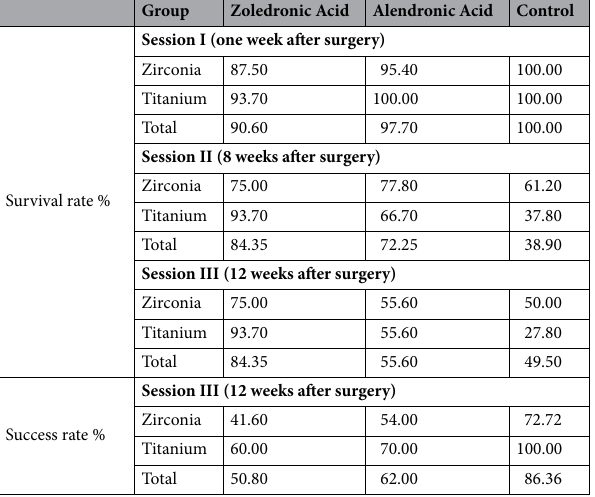
Table 1. Survival and success rates (%) were calculated for titanium and zirconia implants.